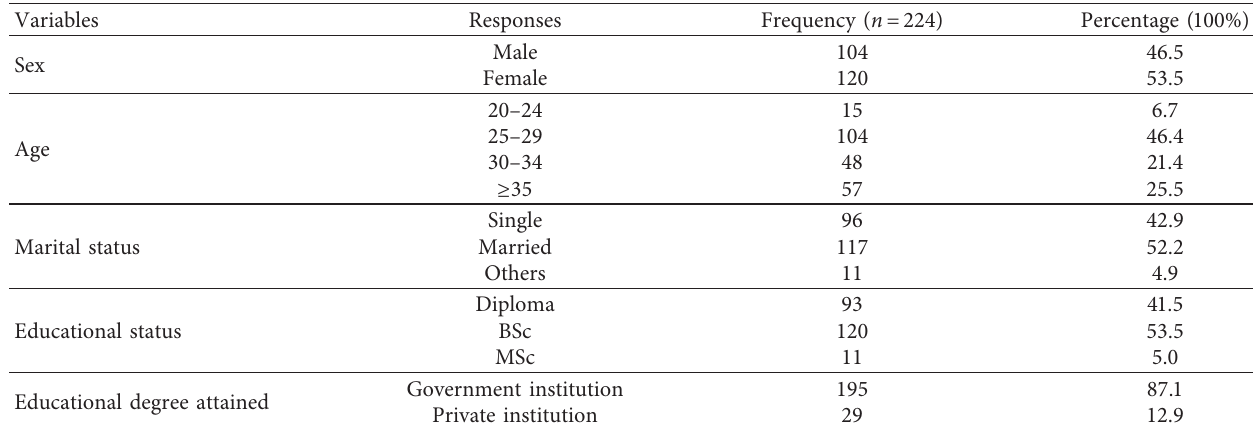
Table 1: Socio-demographic characteristics of nurses working in public hospitals of North 53 Shoa Zone, Amhara, Ethiopia, 2019 ( n � 224).